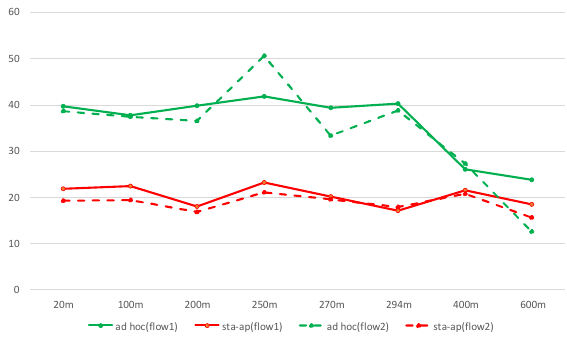
Figure 4. packets/s with different